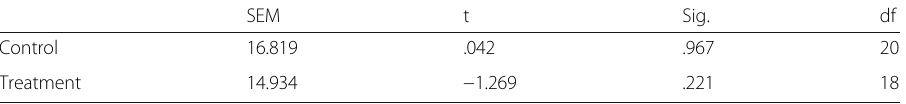
Table 4 Cross-Comparison of Groups ’ EI Ability across Test Conditions